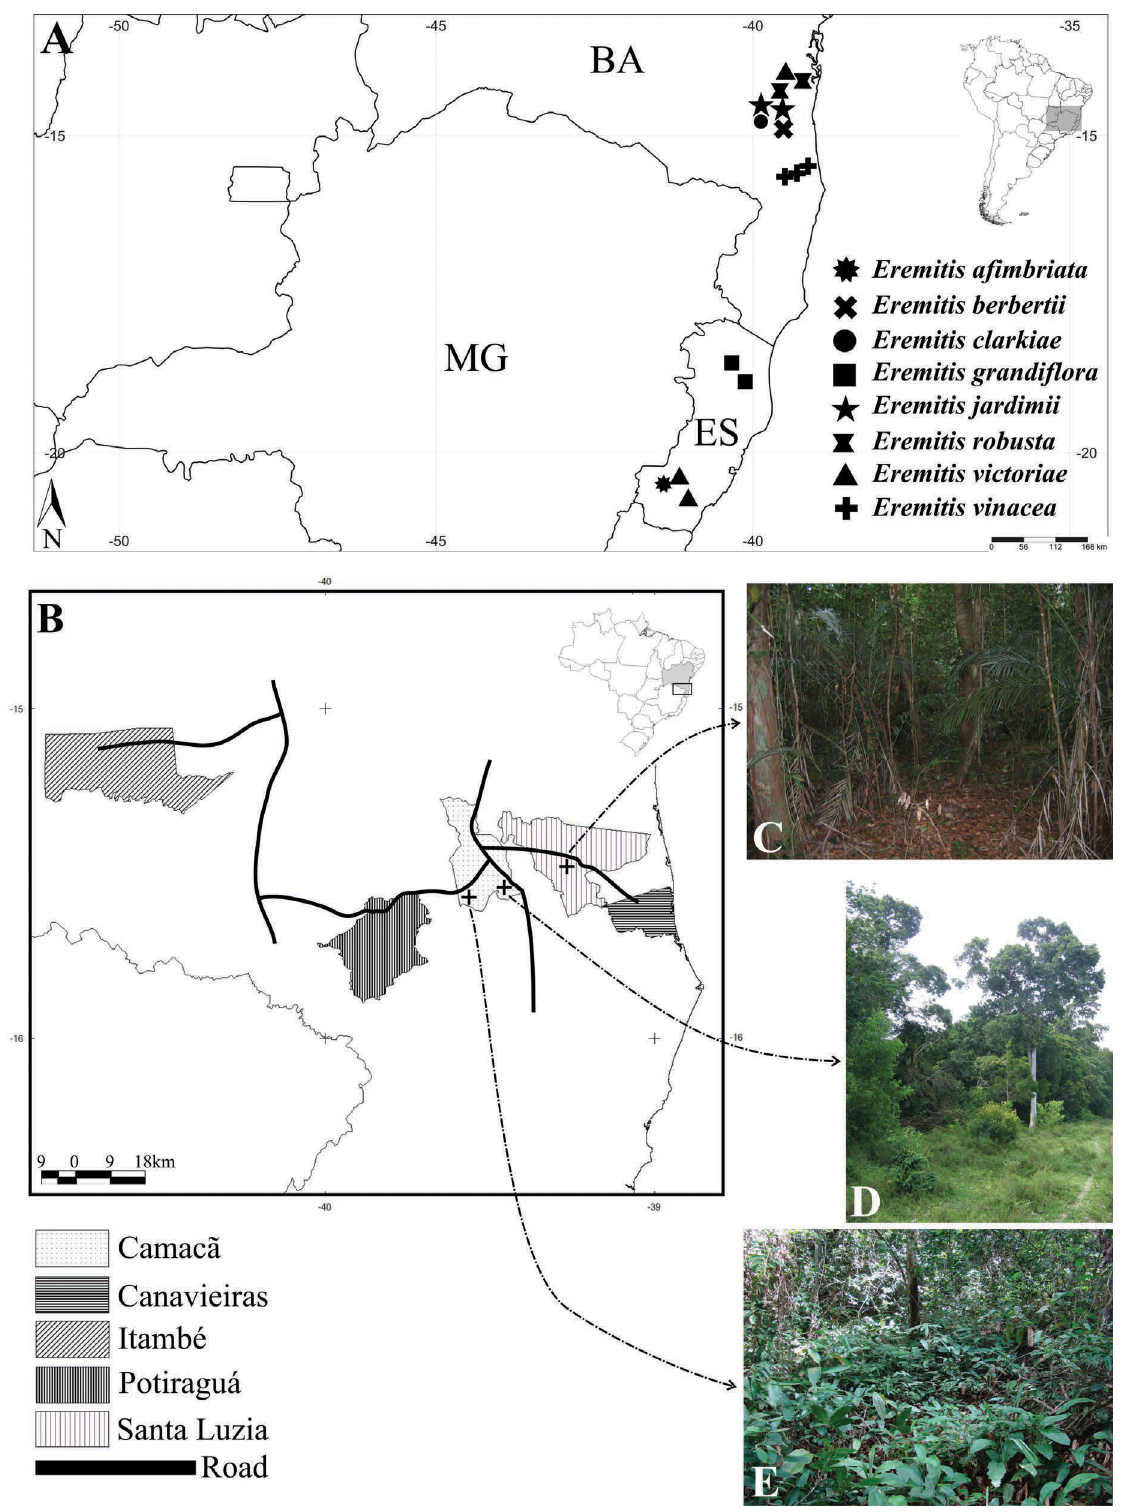
Figure 3 – A . Geographic distribution of Eremitis clarkiae , E. vinacea , and morphologically similar species (Brazilian state abbreviations: BA – Bahia; ES – Espírito Santo; MG – Minas Gerais). Map created using SimpleMappr (https://www.simplemappr.net/). B . Detail of the distribution of E. vinacea in southern Bahia, showing the three localities where the species was collected. Map created using ArcMap v.9.3 (https://www.arcgis.com, © Esri and its licensors, all rights reserved). C – E . Environments in which E. vinacea occurs (photographs by Fabrício M. Ferreira). C . Submontane tropical moist forest in Lagoa Dourada, municipality of Santa Luzia. D . Ombrophilous forest in Jerusalém Farm, municipality of Camacã. E . Ombrophilous forest between Camacã and Potiraguá (type